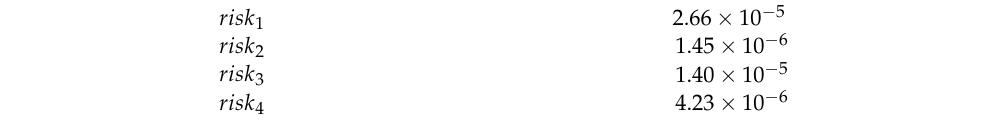
Table 2. Comparison of risk objective function computed with different